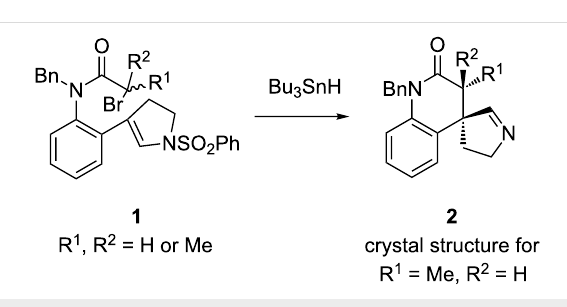
Figure 2: Isolation of stable imines strengthens the case for sulfonyl radical elimination.